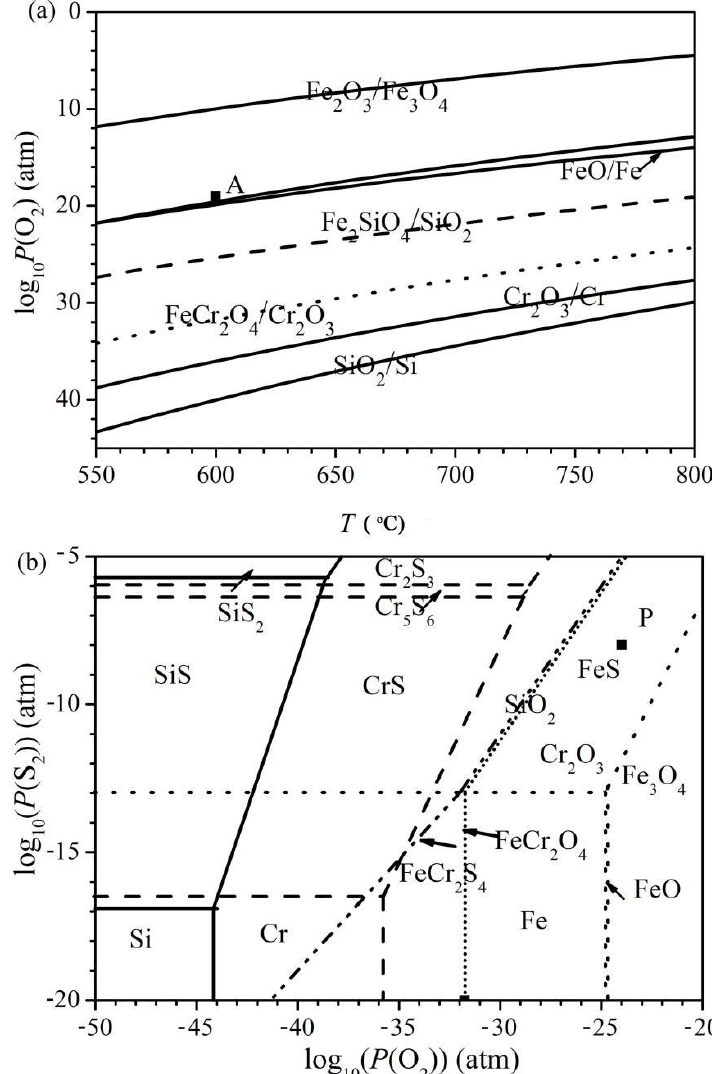
Figure 10. ( a ) Superimposed phase diagram of the binary Fe-O, Si-O and Cr-O systems versus temperature with an indication of the oxygen pressure used in this work, point A. ( b ) Superimposed phase diagram of the ternary Fe-O-S (dot lines), Cr-O-S (dashed lines) and Si-O-S (solid lines) systems at 600 °C with an indication of the oxygen and sulphur pressures used in this work, point P.